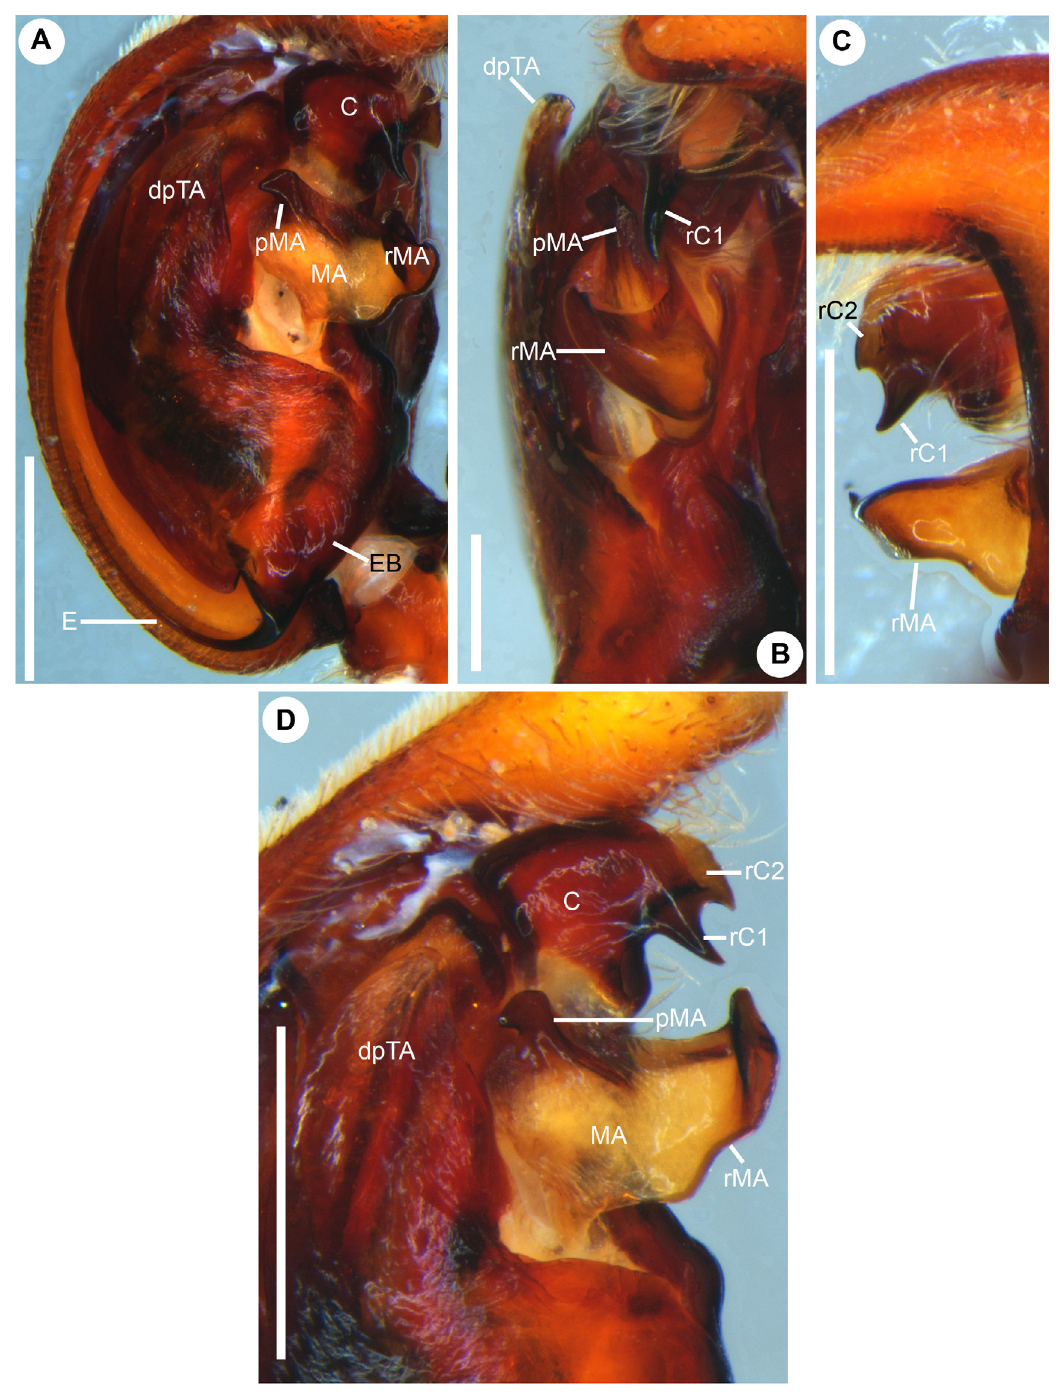
Fig. 5. Laminion birenifer (Gravely, 1921) gen. et comb. nov., ♂, syntype of Storena birenifer Gravely, 1921 (NZC-ZSI-2914/H2), details of left pedipalp. A . Bulb, prolatero-ventral view. B – D . Details of conductor, median apophysis and disto-prolateral tegular apophysis. B . Ventro-retrolateral view. C . Oblique ventral view. D . Prolateral view. Abbreviations: C = conductor; dpTA = disto-prolateral tegular apophysis; E = embolus; EB = embolic base; MA = median apophysis; pMA = prolateral branch of median apophysis; rC1 = first retrolateral branch of conductor; rC2 = second retrolateral branch of conductor; rMA = retrolateral branch of median apophysis. Scale bars: A, C = 0.5 mm; B, D = 0.2